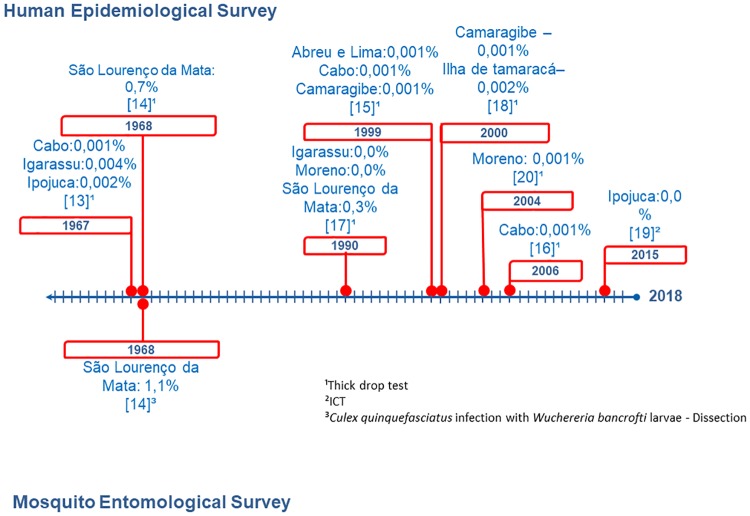
Landmarks in the evolution of epidemiology and entomological surveys in Pernambuco.